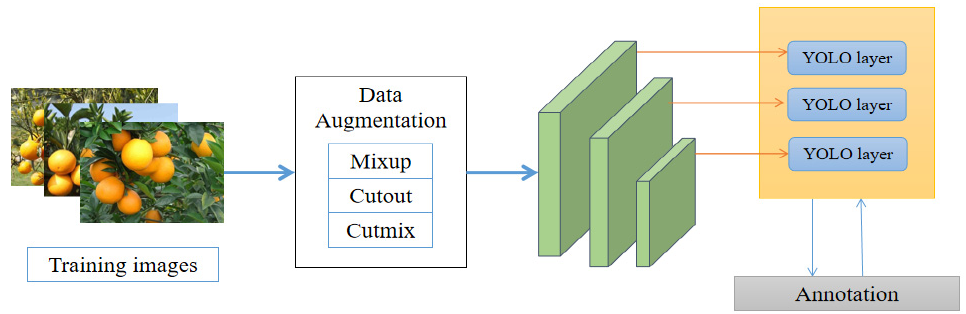
Figure 4. The YOLOv5 model structure diagram. We used three data enhancement methods during training.